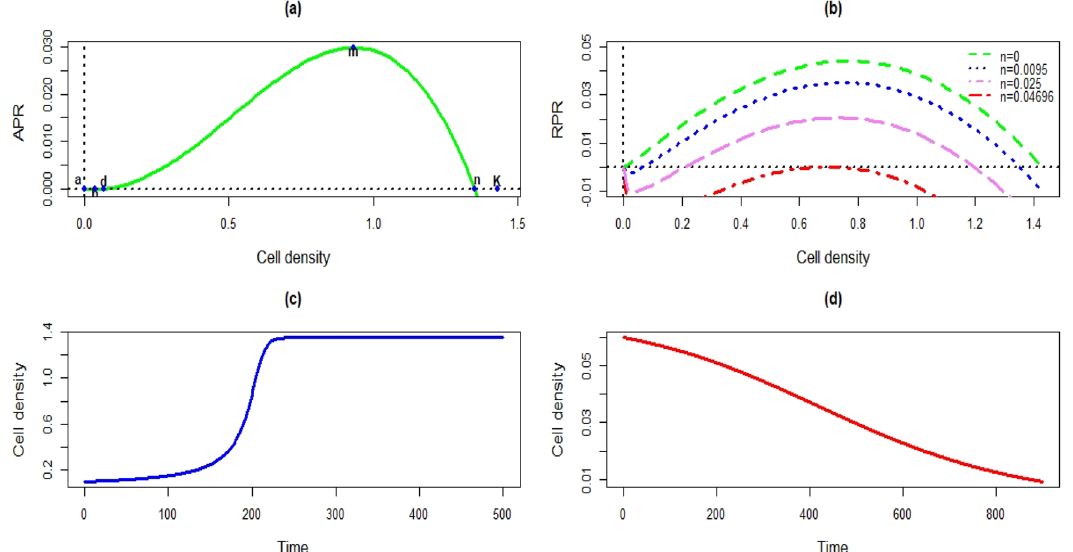
Figure 1. Growth dynamics of the proposed model: ( a ) Absolute proliferation rate (APR) profile considering r p 0.13 , K 1.43 , n 0.0095 , α 1.15 , β 0.2 ; ( b ) RPR profiles for different n and other 0.99 and δ = = = = = = 0.13 , K 1.43 , n 0.0095 , α 1.15 , same constant model parameters; ( c ) Cell population survive for r p = = = = 0.2 with the initial cell density 0.1; ( d ) The population goes to extinction for the initial cell 0.99 and δ β = = density 0.06 with the same constant